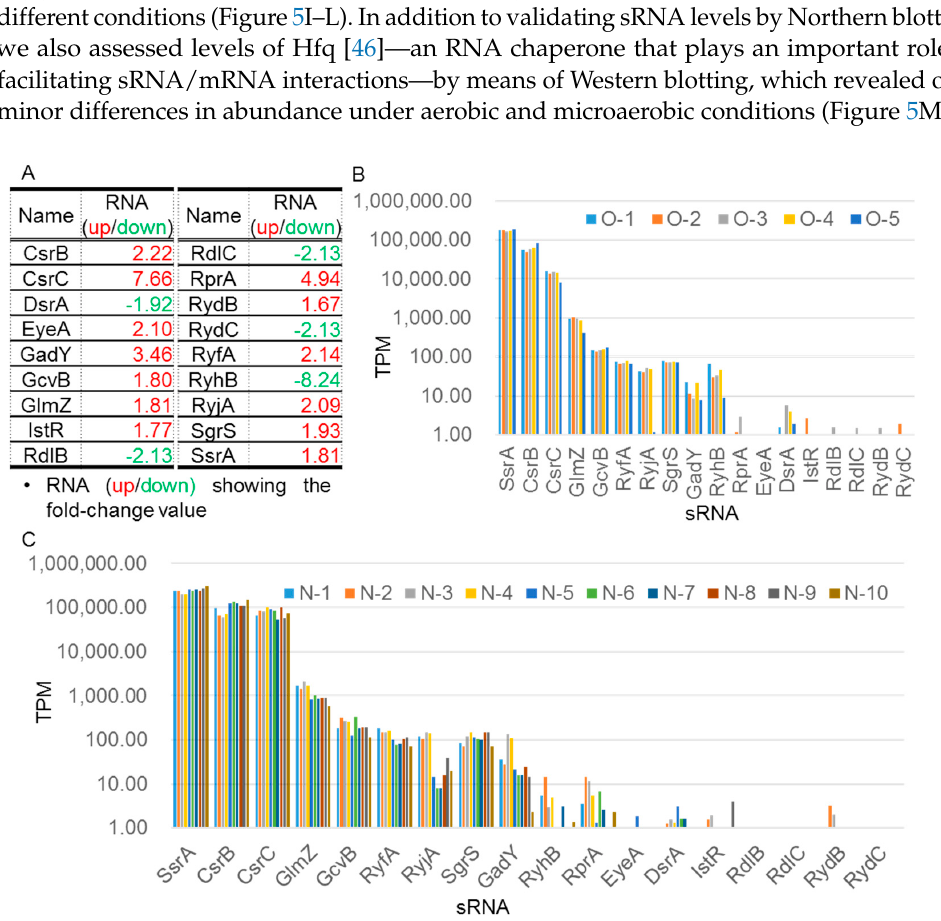
Figure 3. Higher fold-change expression and individual TPM values for known E. coli sRNAs detected under microaerobic versus aerobic conditions. ( A ) The fold-change values for upregulated and downregulated sRNAs are shown in red and green, respectively. ( B , C ) The y axis shows logarithmic TPM expression values for sRNAs expressed in aerobic ( B ) and microaerobic ( C ) cultures, respectively. The x axis shows the sRNAs listed in ( A ). The individually colored bars represent different biological replicates as